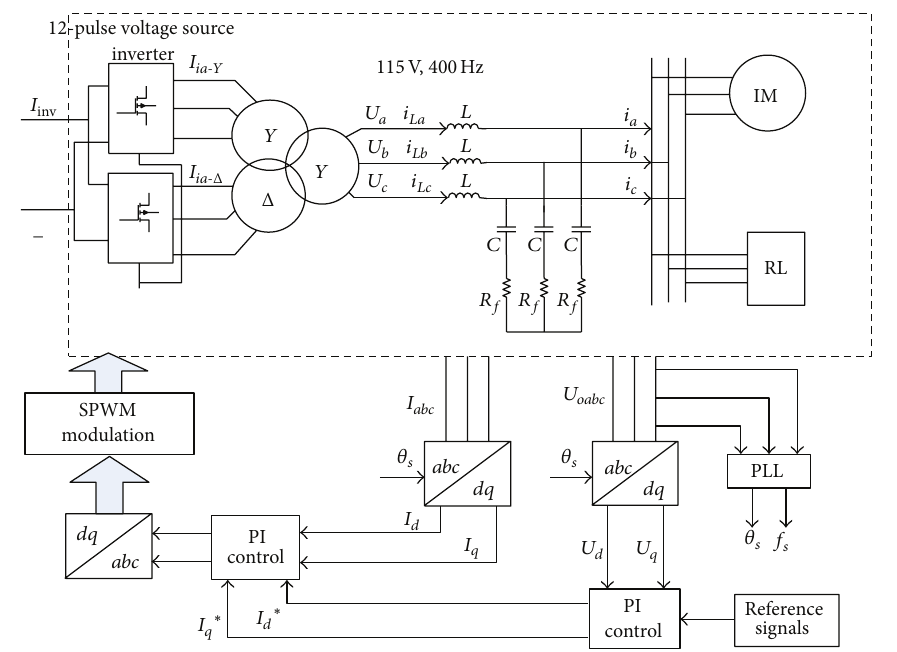
Figure 4: Structure of inverter module.